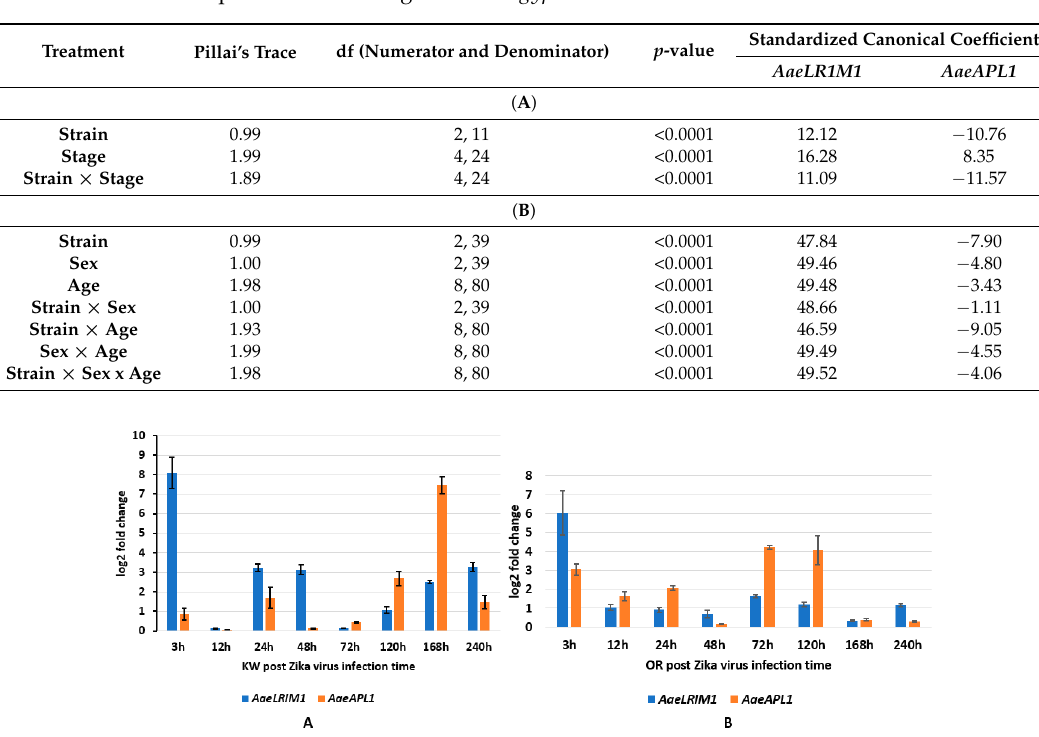
Table 2. ( A ) MANOVA results for strain and stage effects of the AaeLRIM1 and AaeAPL1 RNA profile in immature stages of Ae. aegypti . ( B ) MANOVA results for strain, sex, and age effects of the AaeLRIM1 and AaeAPL1 RNA profile in adult stages of Ae. aegypti .